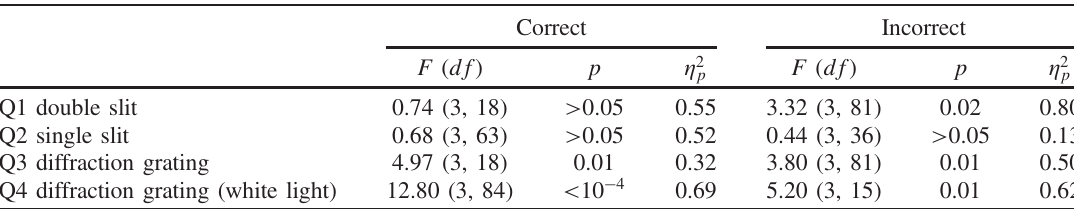
TABLE III. Results of the one-way ANOVAs conducted on dwell times for multiple-choice answers ( a , b , c , and d ) for each question, separately for students who correctly and incorrectly answered the